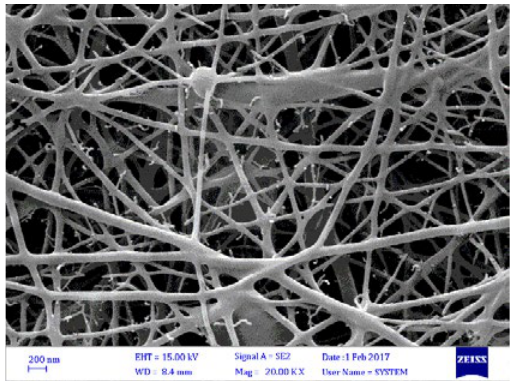
Fig. 1. SEM image of electrospun CS/PEO nanofiber Fig.1 SEM image of electrospun CS/PEO nanofiber